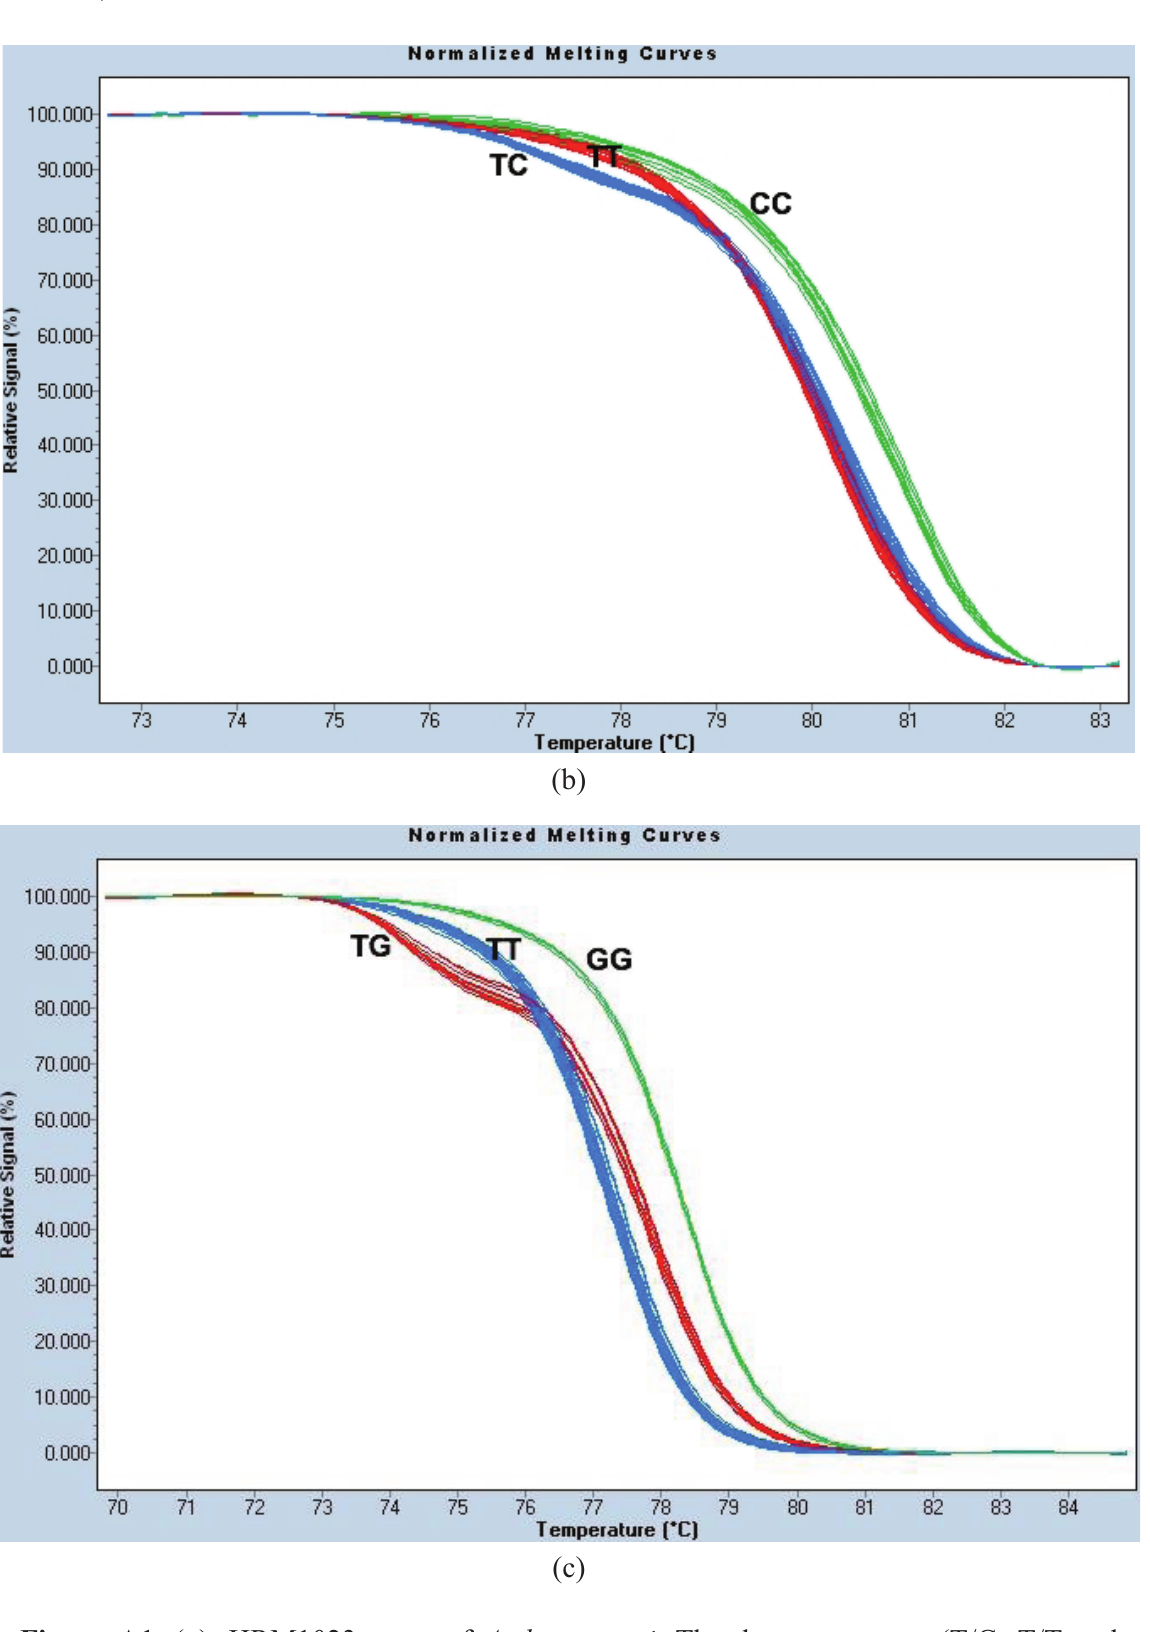
Figure A1. ( a ). HRM1023 assay of Aedes aegypti . The three genotypes (T/G, T/T and G/G) at site 1023 produce distinct melt curves; ( b ). HRM996 assay of Aedes aegypti . The three genotypes (T/C, T/T and C/C) at site 996 produce distinct melt curves; ( c ). HRM1565 assay of Aedes aegypti . The three genotypes (T/G, T/T and G/G) at site 1565 produce distinct melt curves. All genotypes were validated by amplicon